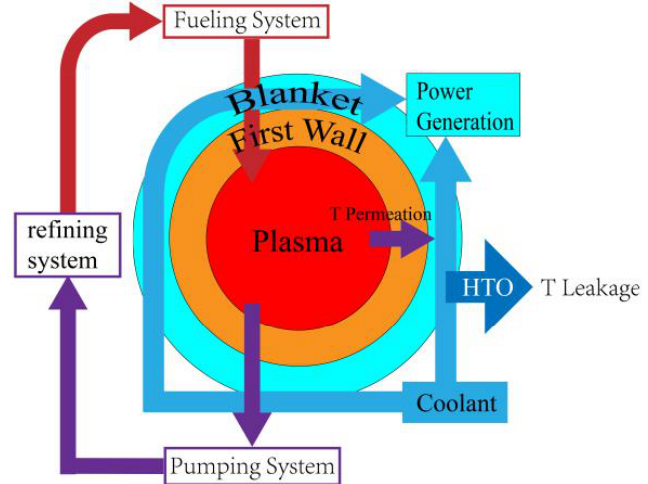
Figure 1. Tritium cycle and leakage in fusion reactor [2,4].